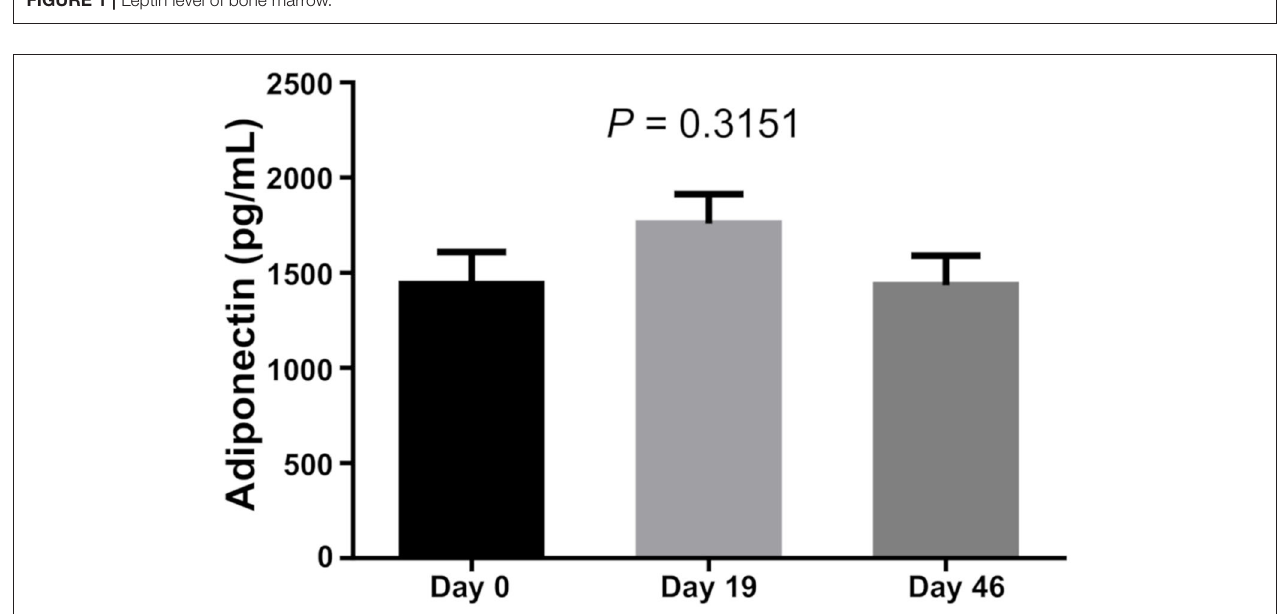
FIGURE 2 | Adiponectin level of bone